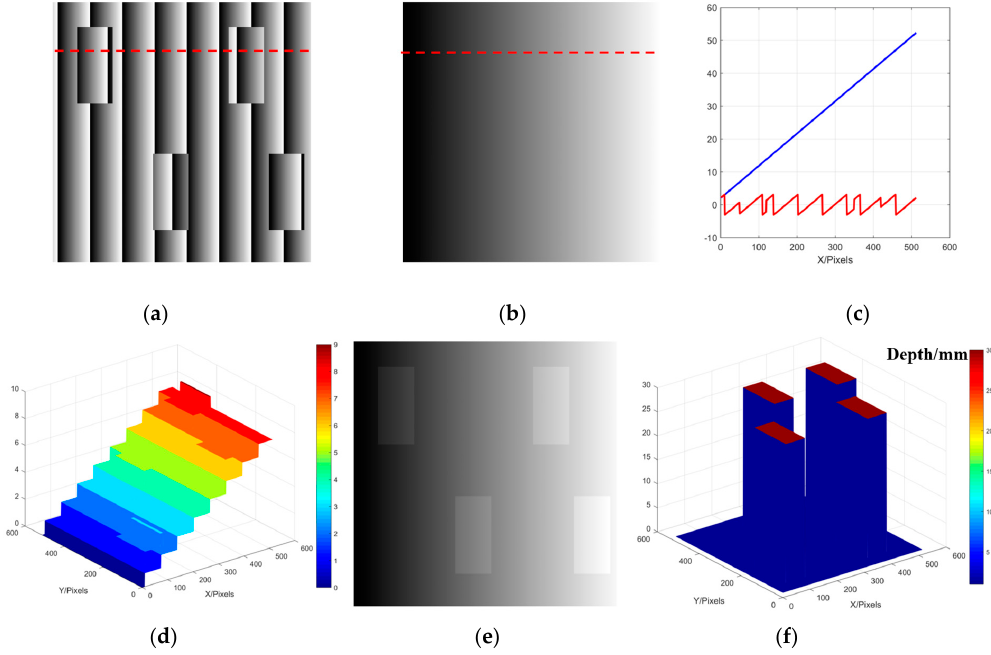
Figure 1. Schematic diagram of phase unwrapping based on reference plane; ( a ) Wrapped phase of the measured object; ( b ) Unwrapped phase of the reference plane; ( c ) 100th row of the wrapped phase and the unwrapped phase of the reference plane; ( d ) Value of the order K; ( e ) Unwrapped phase of the measured object; ( f ) Reconstructed result of measured objects.